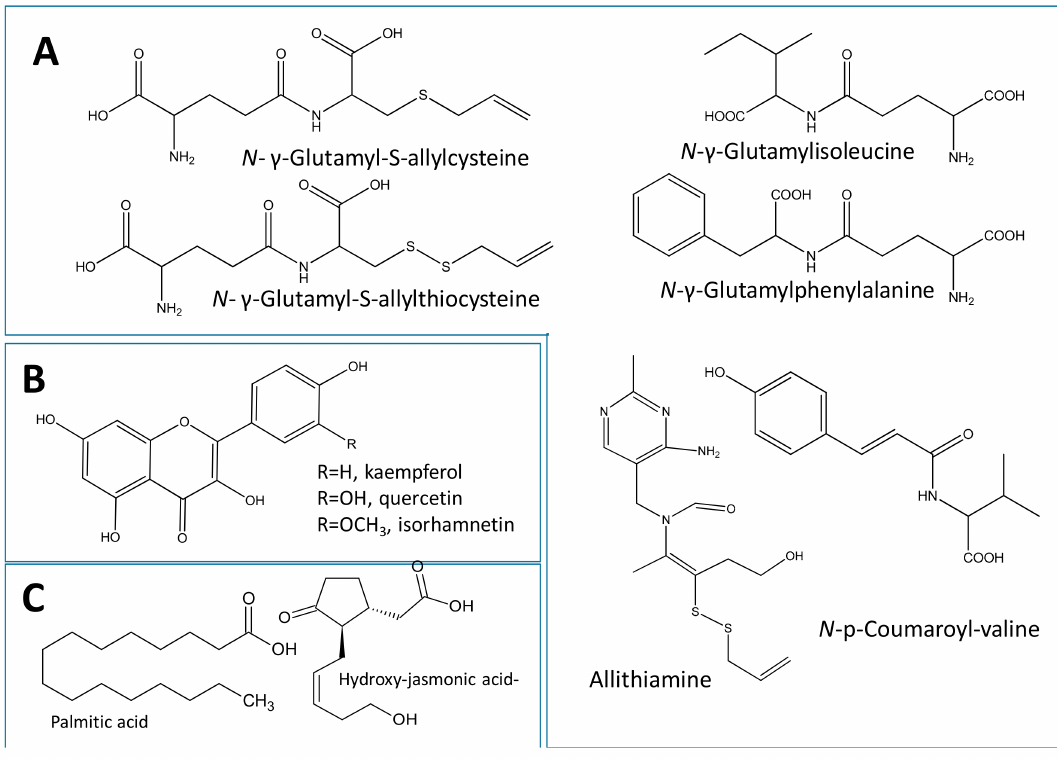
Figure 3. Examples of natural product classes reported and detected in genus Allium via UPLC/MS with selected compound(s) discussed in the manuscript. ( A ) Peptides and amino acids; ( B ) flavonols and ( C ) fatty